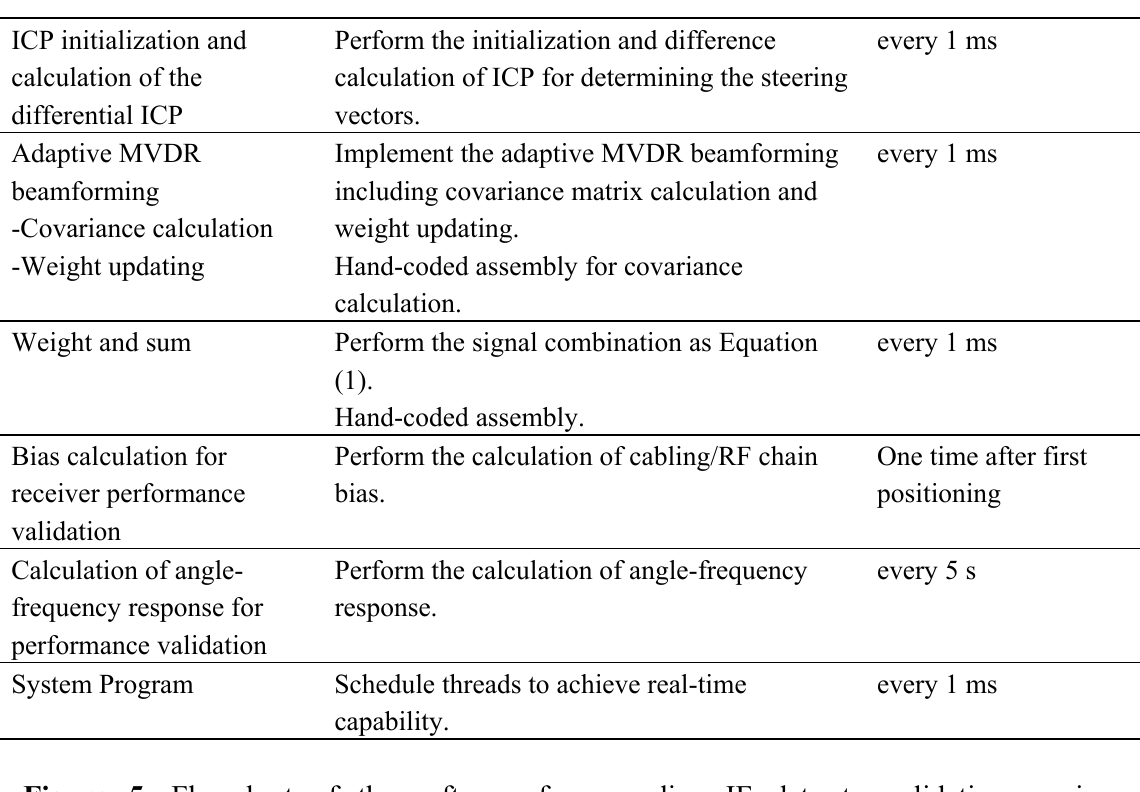
Figure 5. Flowchart of the software from reading IF data to validating receiver